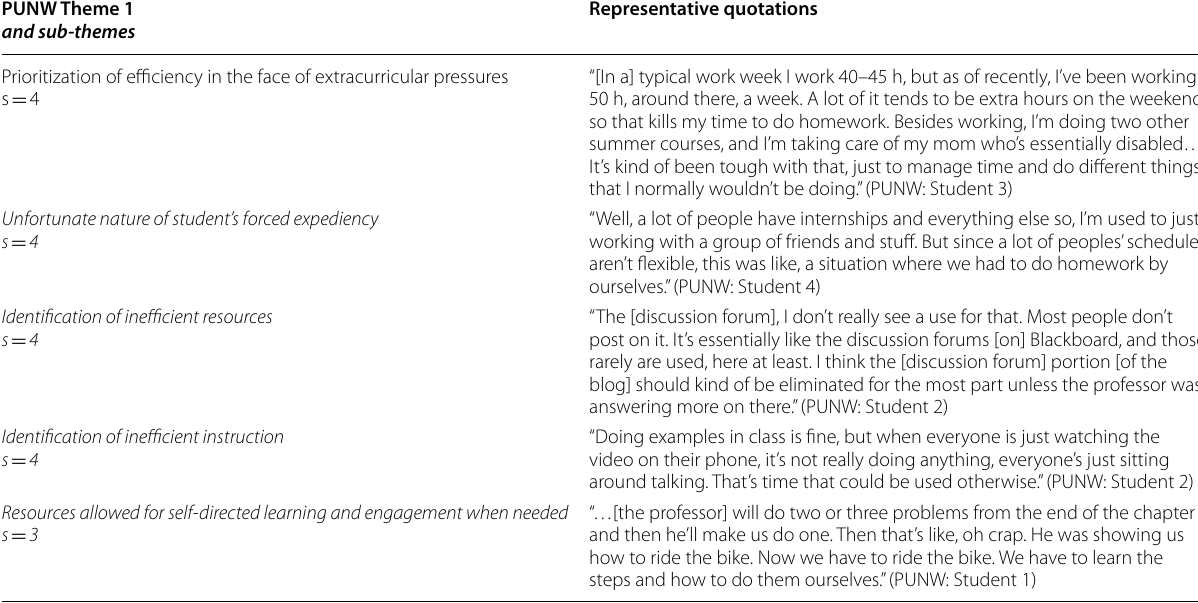
Table 6 PUNW institutional analysis—Theme 1 PUNW Theme 1 and